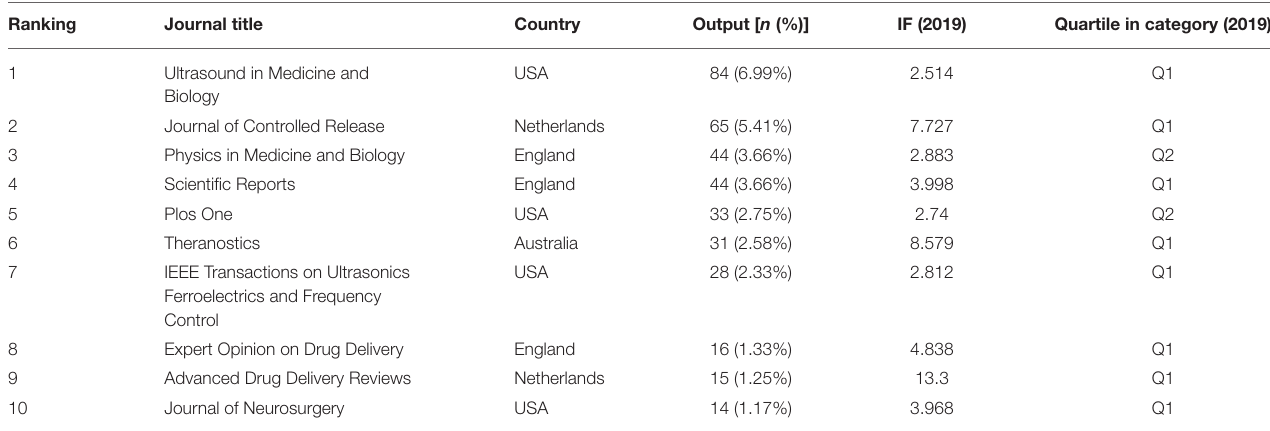
TABLE 1 | The top 10 productive journals that published articles on ultrasound-induced BBB